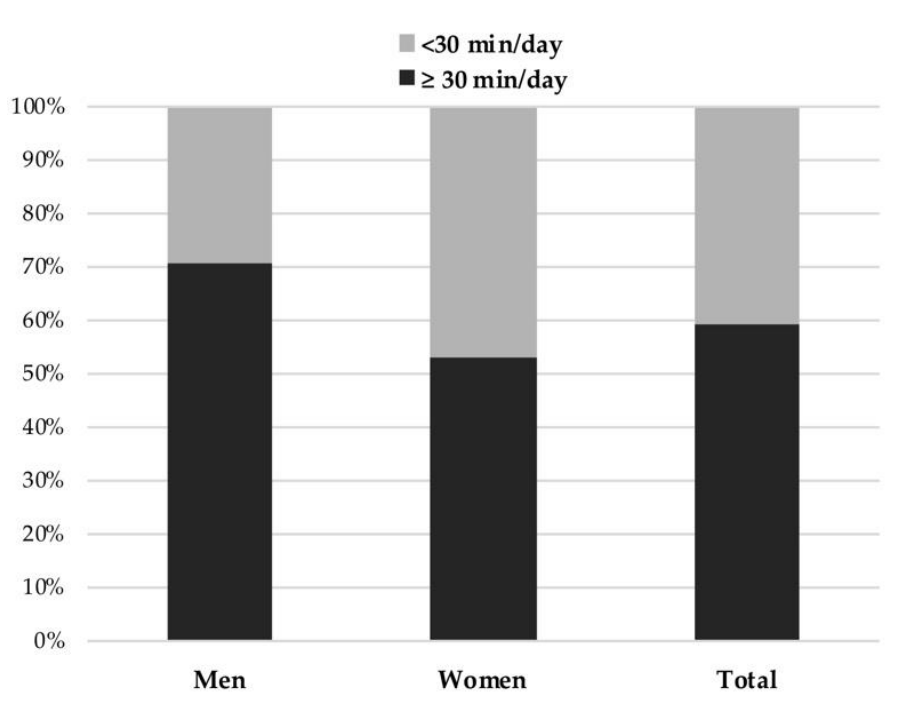
Figure 1. Proportion of participants who accumulated at least 30 min per day of moderate to vigorous physical